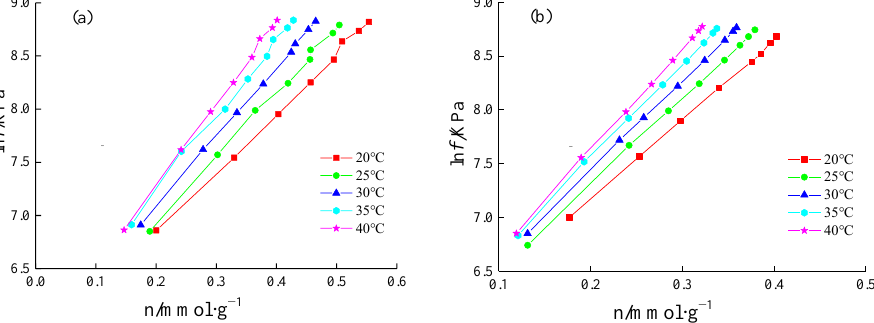
Figure 5. ln f -n relationship of methane adsorption in the isothermal adsorption experimental: ( a ) vitrain; ( b ) durain.